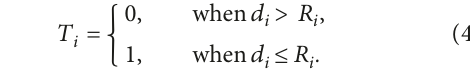
Figure 17: Schematic of a heat map visualization.